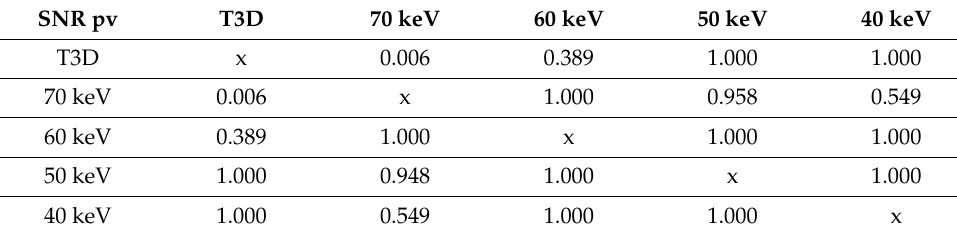
Table 8. Comparison of portal venous SNR between T3D and low keV images.